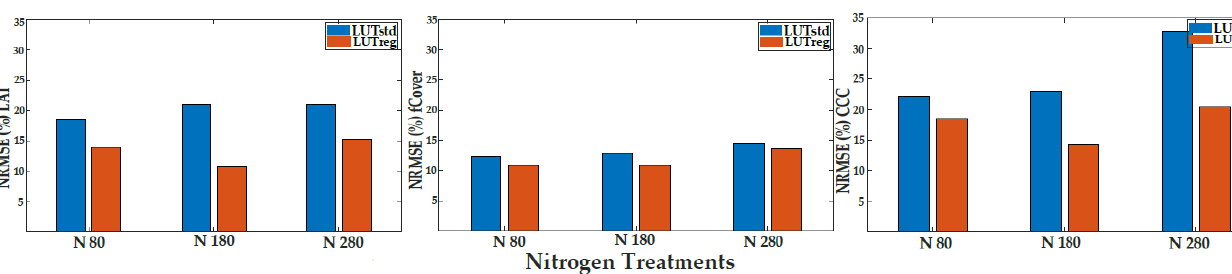
Figure 3. The coefficient of determination (R 2 ) obtained from LUTreg and LUTstd in predictions of LAI, fCover, and CCC at three levels of nitrogen.